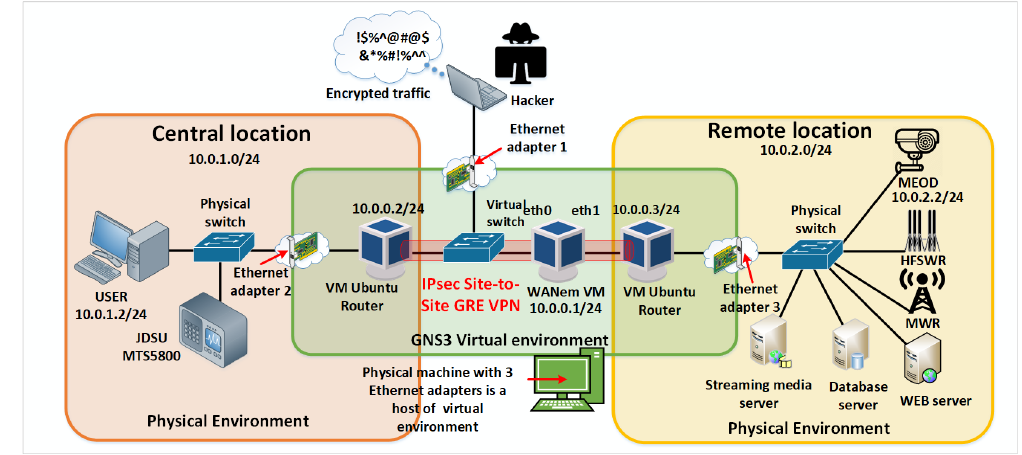
Figure 8. Site-to-site IPsec Virtual Private Network (VPN).